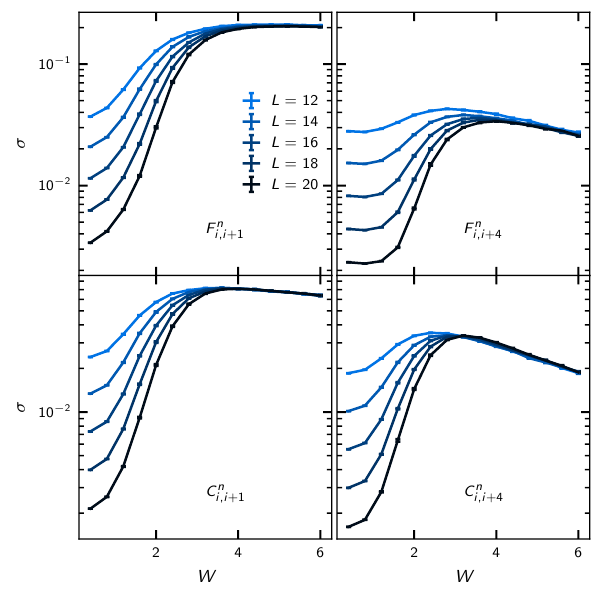
Figure 3: Standard deviation of the difference between adjacent eigenstates of spin- flip operator (upper panels) F n z correlation (lower panels) C n have used the shorter notation 〈 n | S z